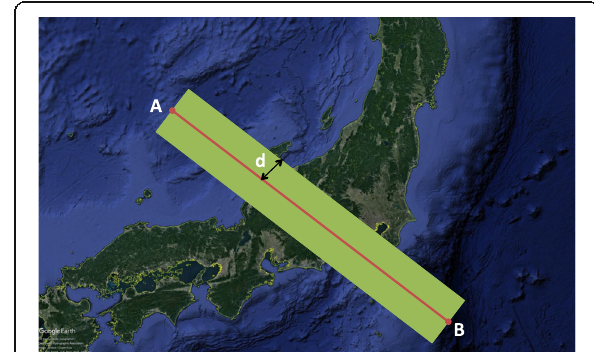
Fig. 2 Selection of the search region in the database system. Users input the latitudes and longitudes of points (A) and (B) to draw a profile (red line) and then set the distance from the profile (d) within which to capture model data (green rectangular region).